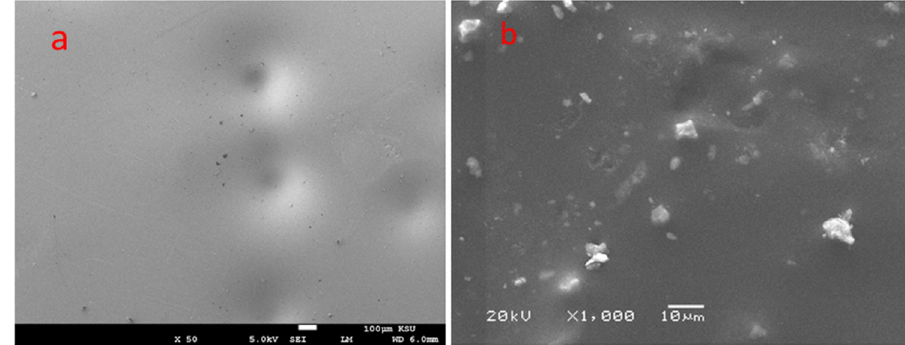
Figure 4: SEM image of ( a ) ROGAU - coated and ( b ) ROGAU - coated CS after immersion.